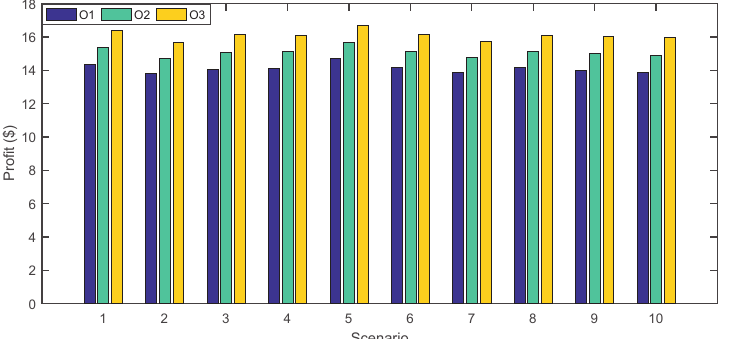
Figure 11. The profits of PEV owners in ten